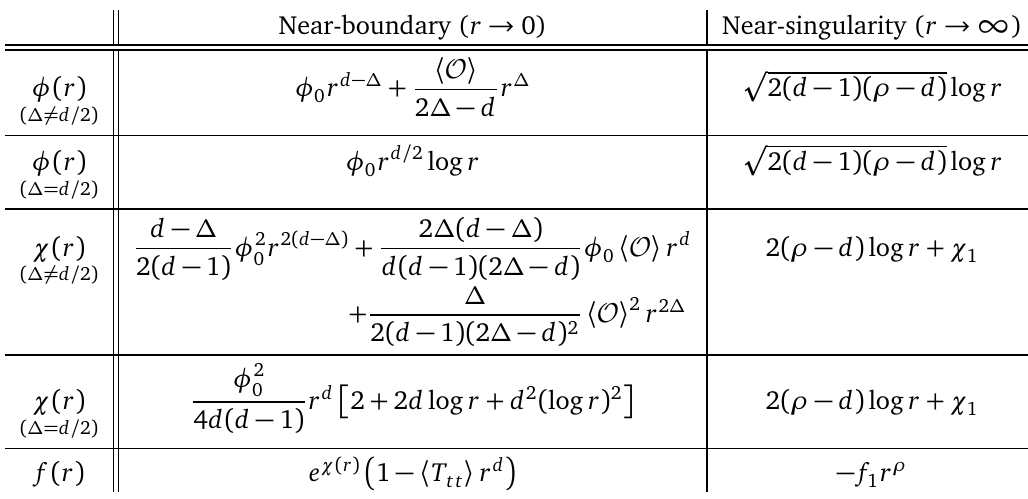
/ T d − ∆ while all of the 0 t